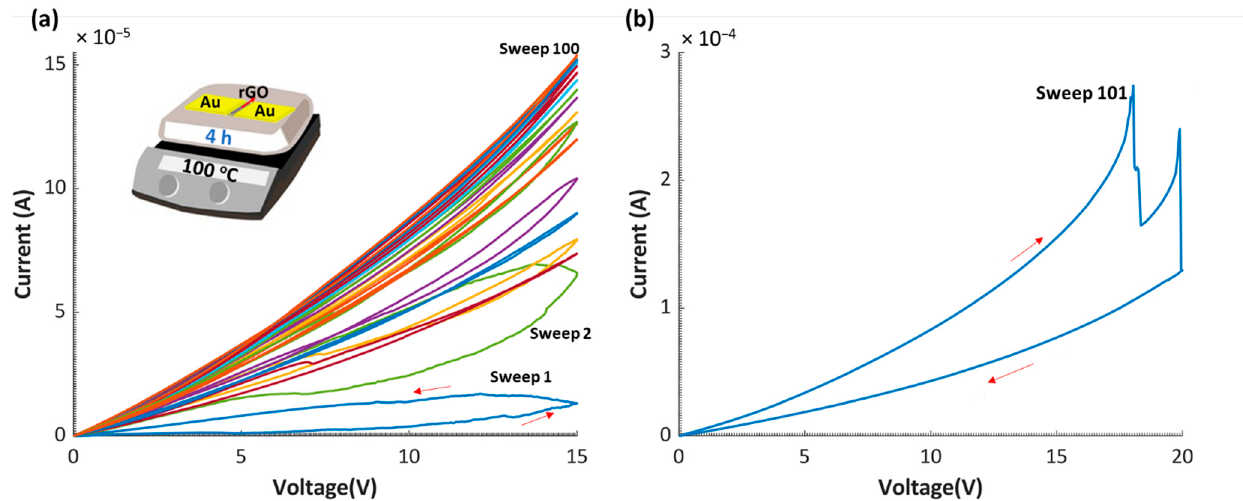
Figure 8. Tunable MR switching behavior. ( a ) A fresh device annealed for 4 h is tested for 100 cycles under the application of 15 V sweep. ( b ) I–V curve under the application of 20 V sweep for the same device after performing the test in ( a ).